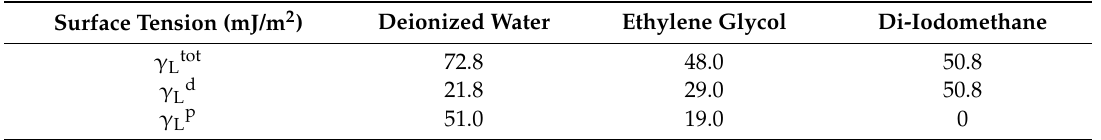
Table 2. The surface tension parameters of the liquids used for surface free energy determination. Surface Tension (mJ/m 2